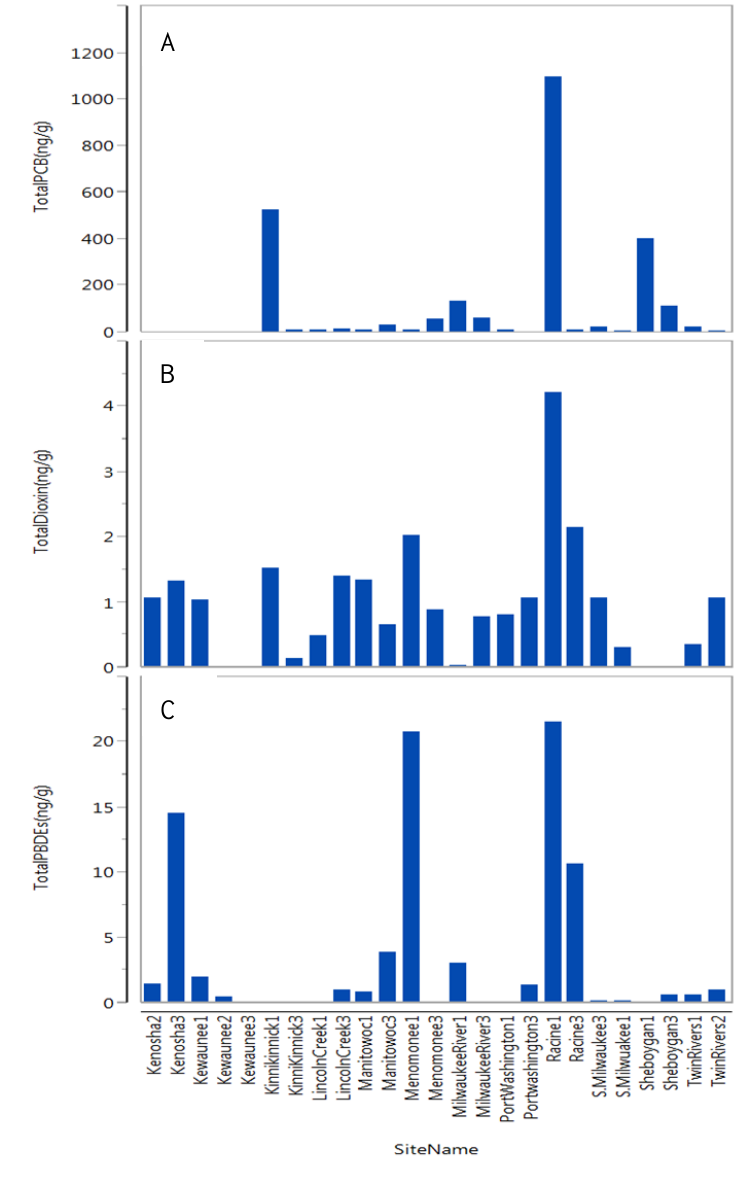
Figure 6. Chemical contaminates ng/g sediment from eight cities and four Milwaukee rivers, totaling 25 samples in 12 civil divisions (some upstream, some downstream). The x- axis lists sample codes which name the Milwaukee-bound river or city, 1’s represent furthest downstream (relative to city boundaries) 3’s represent furthest upstream (relative to city boundaries) 2’s represent sites that were either from equally contributing, but separate, watersheds or midstream sites. A. ∑PCB, B. ∑Dioxin, and C.